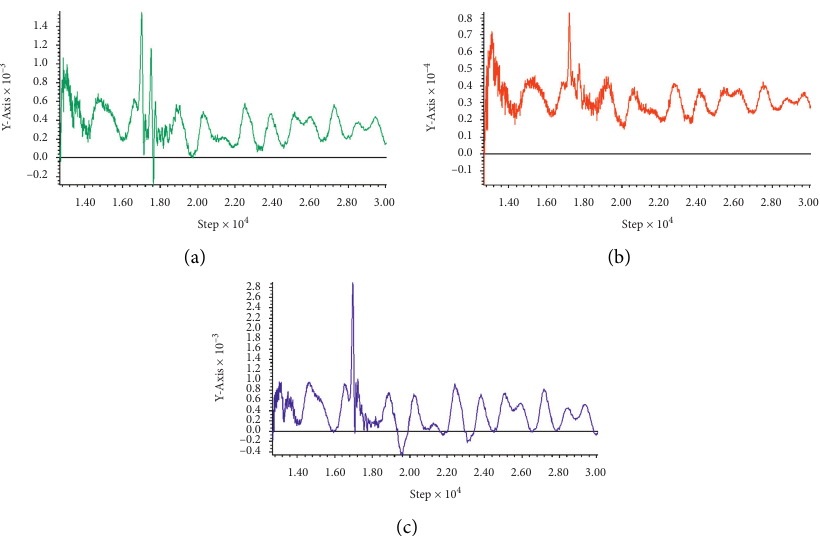
Figure 17: The vibration speed changes when first excavated roadway without support: (a) roof, (b) left side, and (c) right